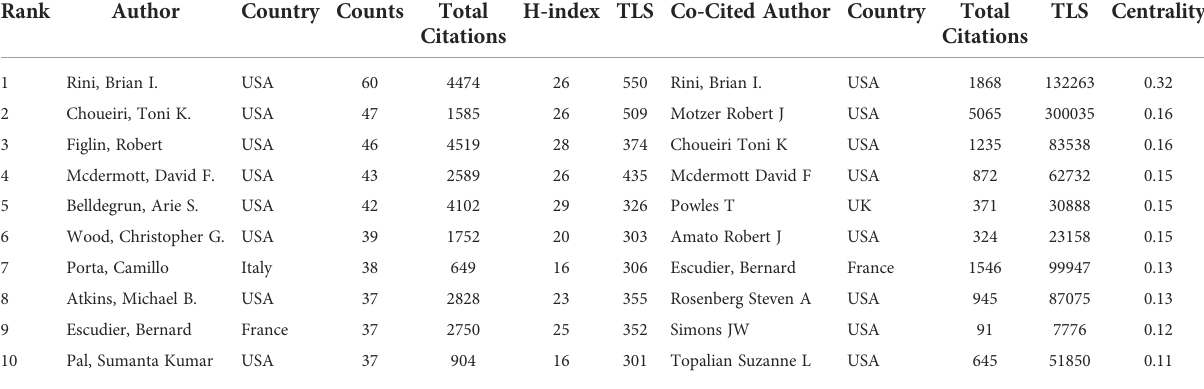
TABLE 3 The 10 most productive authors and the top 10 authors with largest centrality in the fi eld of RCC